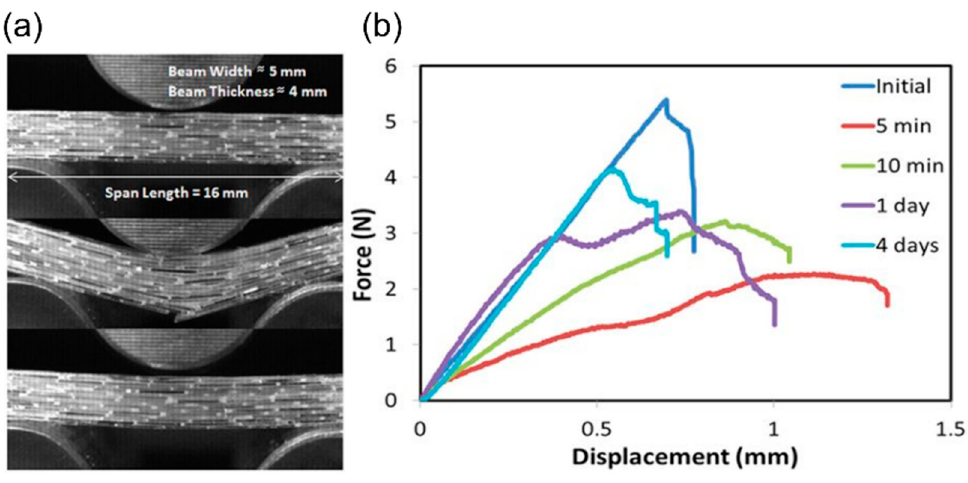
Figure 11. Three-point bending test of the glass–polymer composites with thin glass bricks. ( a ) Images of test samples before (top), during (middle) and after (bottom) fracture. The bottom picture shows that the composite autonomously had reached the initial configuration (top). ( b ) Force–displacement curves of composites. After the test to fracture the samples were left healing at room temperature for various amount of times. Reproduced from [62], CC BY 4.0 [85].